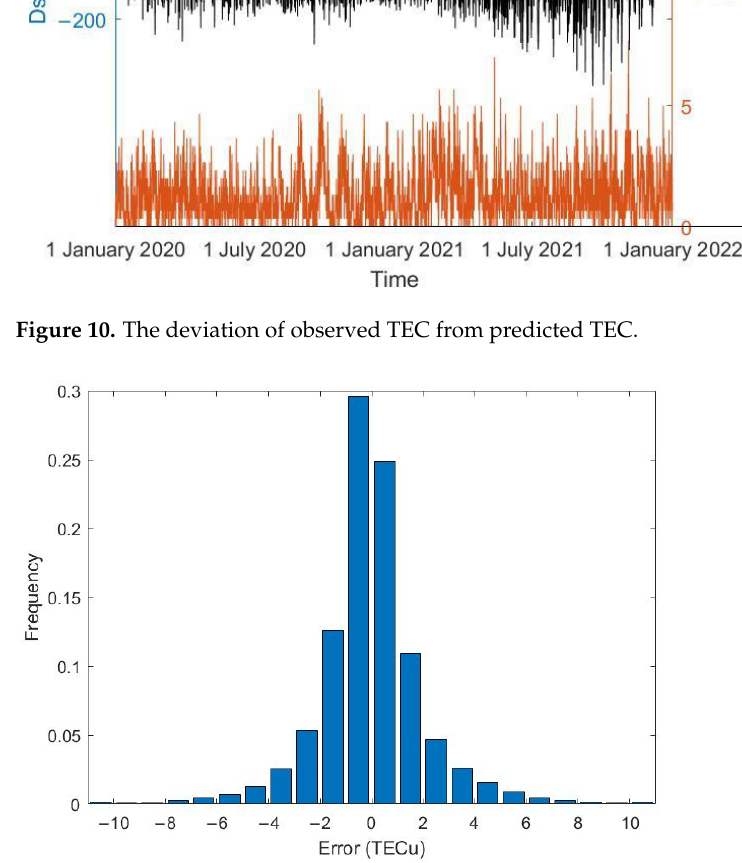
Figure 11. The frequency distribution of the error.